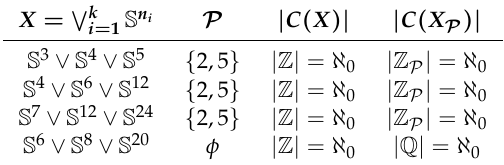
Table 5. The infinite case for k ≥